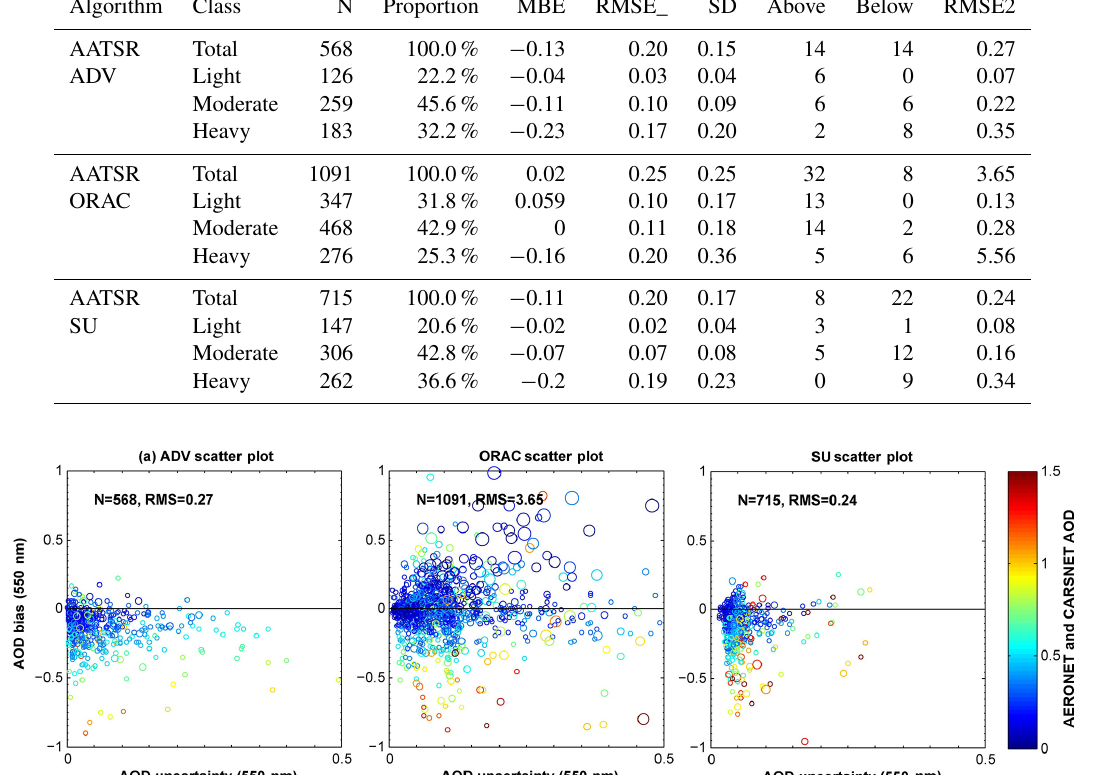
Table 5. Statistics of comparison between AOD bias and ground-based measurements. Proportion is the ratio of the number of bubbles falling in each box to the total number. RMSE1 and RMSE2 are RMSEs of AOD bias with ground-based measurement and AOD uncertainty, respectively.